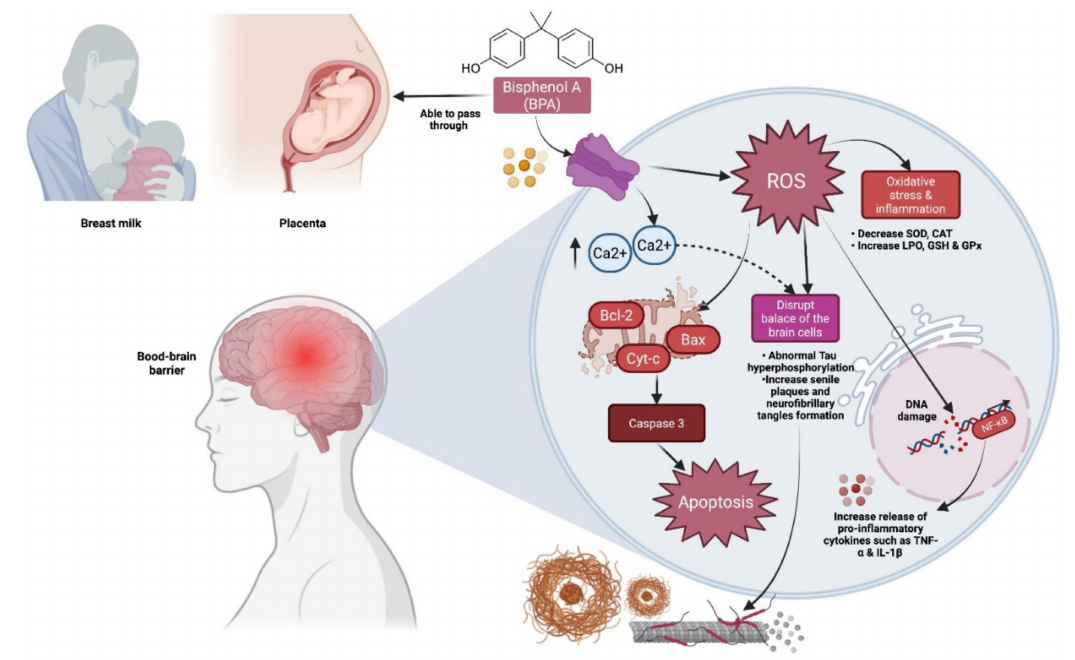
Figure 1. Cognitive impairments caused by BPA have a specific mechanism. BPA can travel past the placenta, the blood–brain barrier, and into breast milk, where it can be passed on to neonates. BPA also elevates reactive oxygen species (ROS) and intracellular calcium (Ca 2+ ), which can lead to hyperphosphorylation of Tau, neurofibrillary tangles, and senile plaques development, resulting in dementia or Alzheimer’s disease (AD). Additionally, BPA has been linked to increases in oxidative stress, inflammation, and apoptosis in